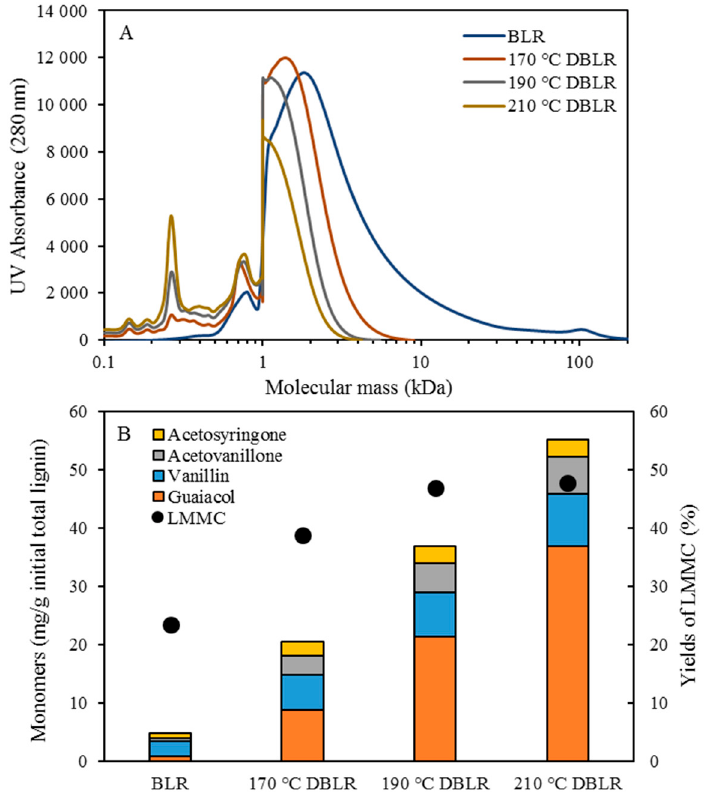
Figure2. CharacterizationofBLRbeforeandafterdepolymerization. ( A )Molecularweightdistributions Figure 2. Characterization of BLR before and after depolymerization. (A) Molecular weight of BLR and depolymerised BLR products, measured as UV absorbance at 280 nm. ( B ) The yields of distributions of BLR and depolymerised BLR products, measured as UV absorbance at 280 nm. (B) lignin low-molecular mass compounds (LMMC) and the concentration of lignin monomers in LMMC The yields of lignin low-molecular mass compounds (LMMC) and the concentration of lignin before and after depolymerization. Depolymerization conditions: 5 times dilution with 2% NaOH, monomers in LMMC before and after depolymerization. Depolymerization conditions: 5 times 170–210 ◦ C, 120 bar, and 2 dilution with 2% NaOH, 170–210 °C, 120 bar, and 2 min.